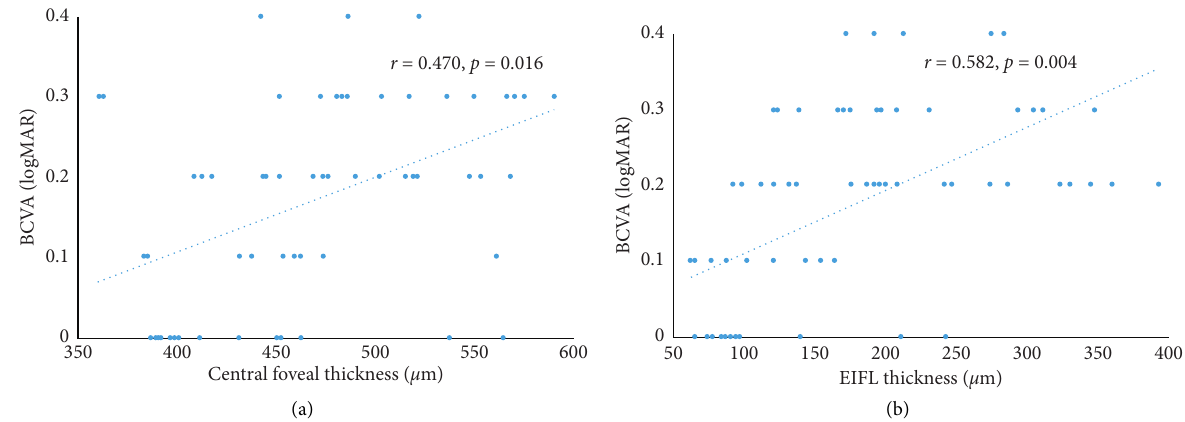
Figure 4: a, b Correlation analysis between postoperative best-corrected visual acuity (BCVA) and the central foveal thickness (CFT) and ectopic inner foveal layer (EIFL) thickness at 12 months after surgery. Optical coherence tomography parameters are significantly associated with postoperative BCVA (CFT: r � 0.470 and p � 0 . 016; EIFL: r � 0.582 and p � 0 . 004). logMAR, logarithm of the minimum angle of